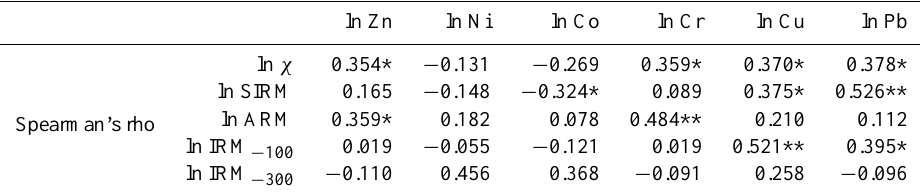
Table 5. Correlation coefficient between heavy metals content and magnetic parameters in topsoils. ln Zn ln Ni ln Co ln Cr ln Cu ln Pb